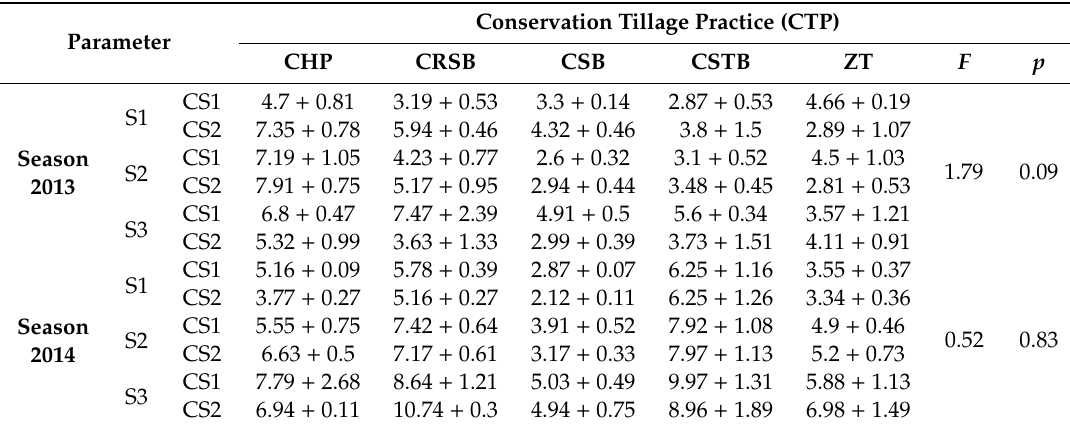
Table 1. The combination of e ff ects of slope, cropping systems, and conservation tillage practices on eroded soil (t ha-1) for both seasons 2013 and 2014.